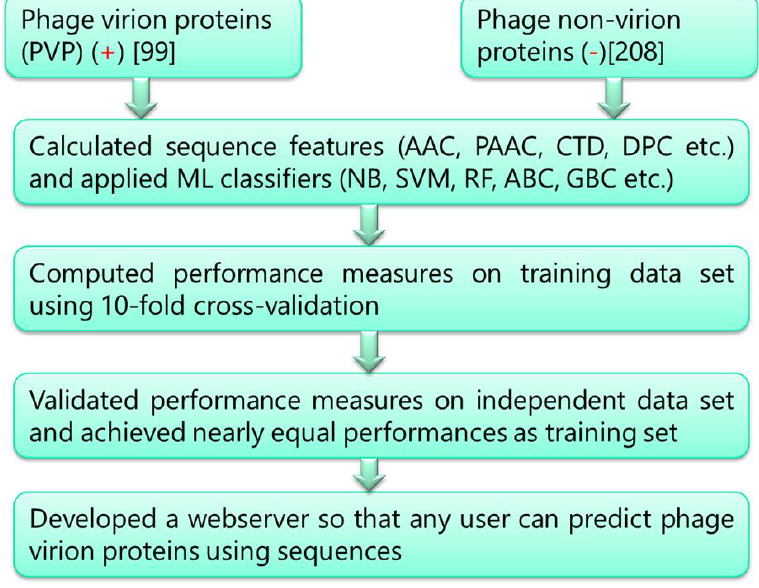
Figure 5. Workflow of the study.